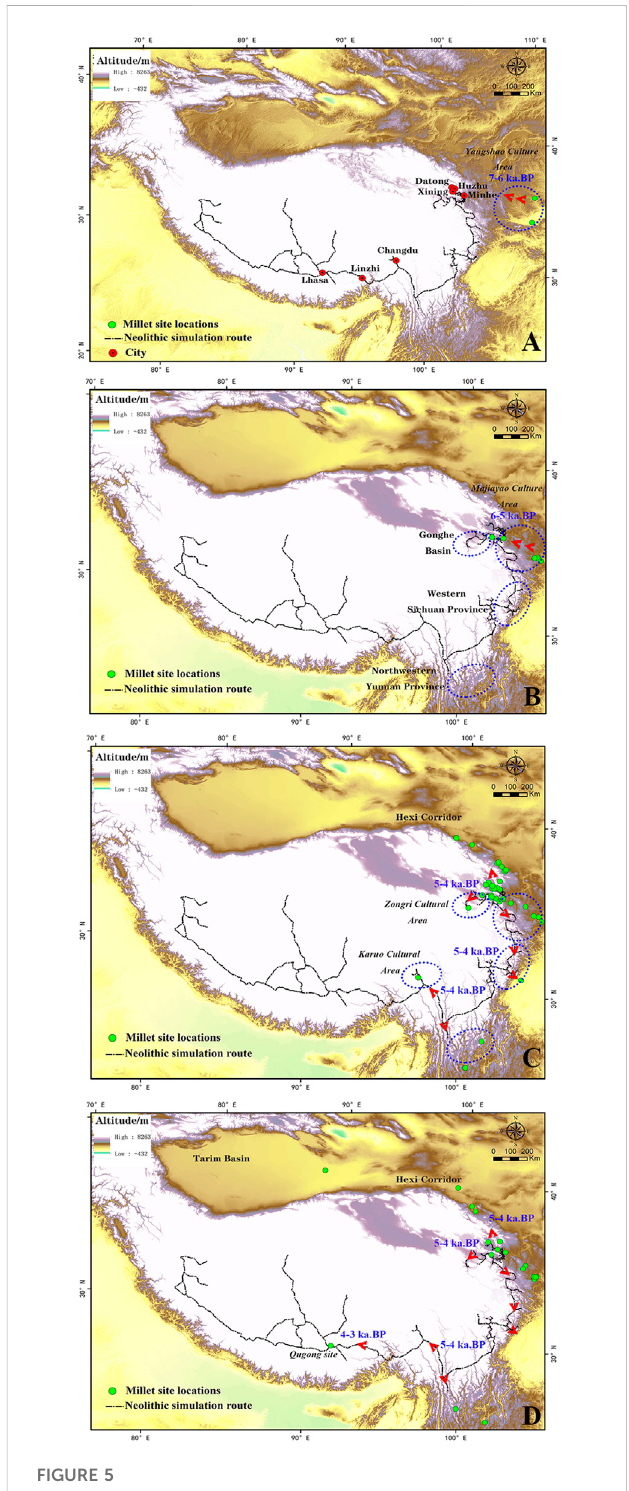
FIGURE 5 Simulatedexchangeroutescomparedwitharchaeologicalevidencefor the spread of millet agriculture in the Neolithic period. (A) 7 – 6ka.BP; (B) 6 – 5ka.BP; (C) 5 – 4ka.BP; (D) 4 – 3ka.BP. Point data of site locations are from Dong et al. (2022a), Dong et al. (2022b). Blue dotted ovals mark the